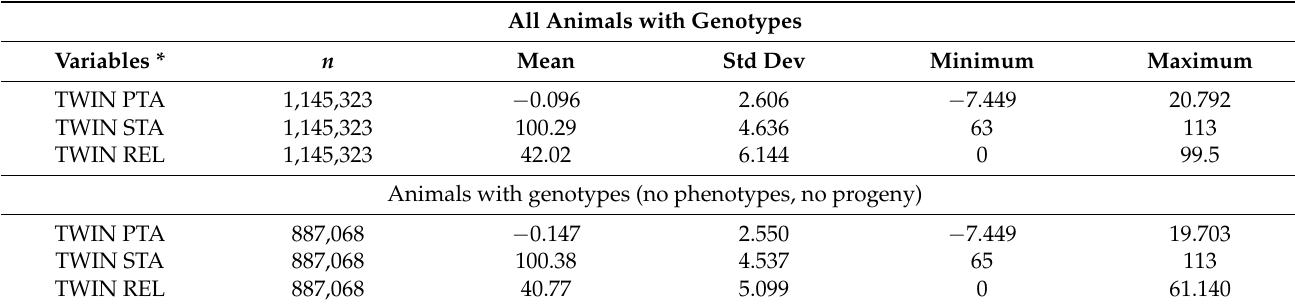
Table 4. Summary statistics for (g)PTAs, STAs, and reliabilities for TWIN predictions as outputted by the genetic evaluation for (1) all Holsteins with genotypes, phenotypes and/or progeny and (2) Holsteins with genotypes only in the evaluation.